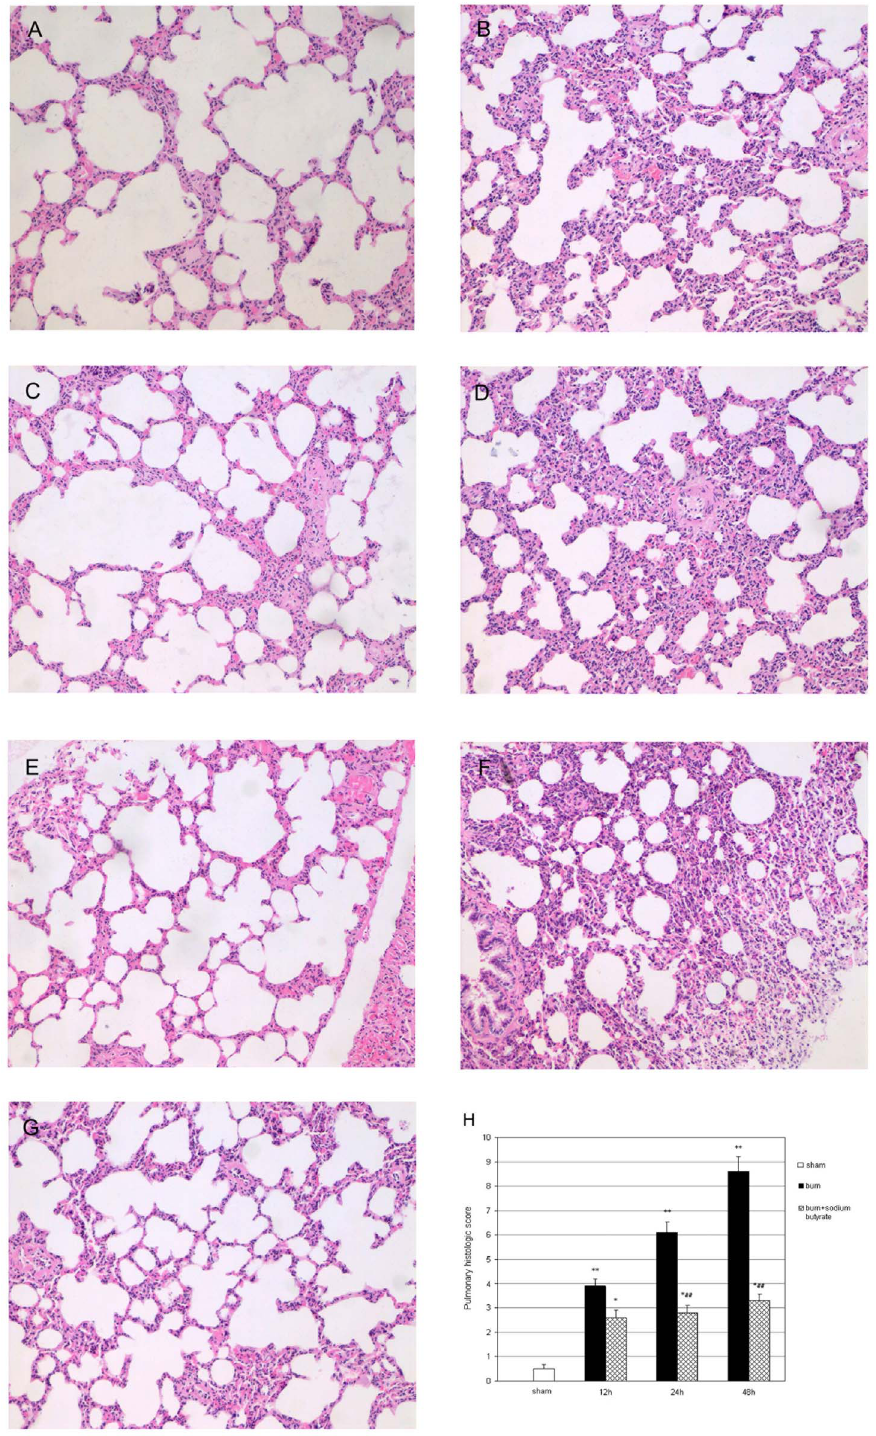
Figure 3. Effect of sodium butyrate on histopathologic changes in rats with burn-induced ALI ( 6 100). Representative photomicrographs showing hematoxylin and eosin staining: lung edema, alveolar hemorrhage, and neutrophil infiltration. The epithelial and endothelial cell structure was destroyed in the burn group. Meanwhile, these changes were not identified or were less severe in the burn plus sodium butyrate group. The gradually increase in pulmonary histologic score started at 12 h after burn injury, and was significantly attenuated by sodium butyrate treatment. (A) Sham group, (B) burn group at 12 h post burn, (C) burn plus sodium butyrate group at 12 h post burn, (D) burn group at 24 h post burn, (E) burn plus sodium butyrate group at 24 h post burn, (F) burn group at 48 h post burn, (G) burn plus sodium butyrate group at 48 h post burn, and (H) changes in the pulmonary histologic scores. Results are given as mean 6 SEM (n=8). *p , 0.05, **p , 0.01, vs. sham, ANOVA; ## p , 0.01, vs. related burn group, ANOVA.